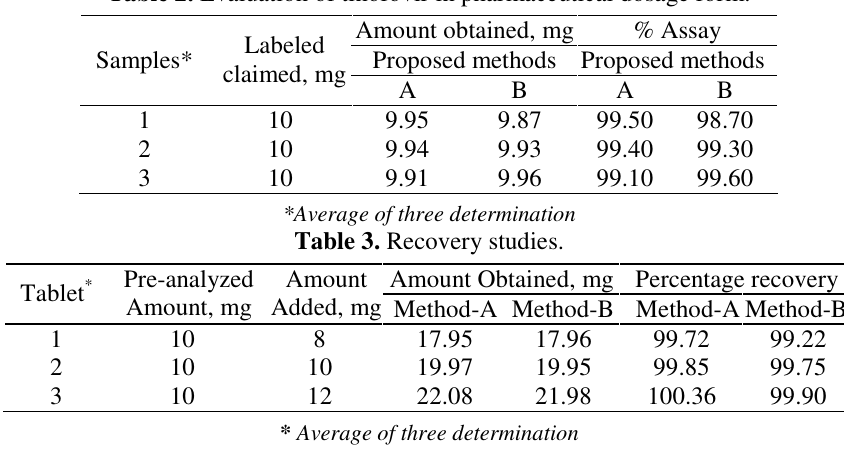
Table 2. Evaluation of tinofovir in pharmaceutical dosage form.